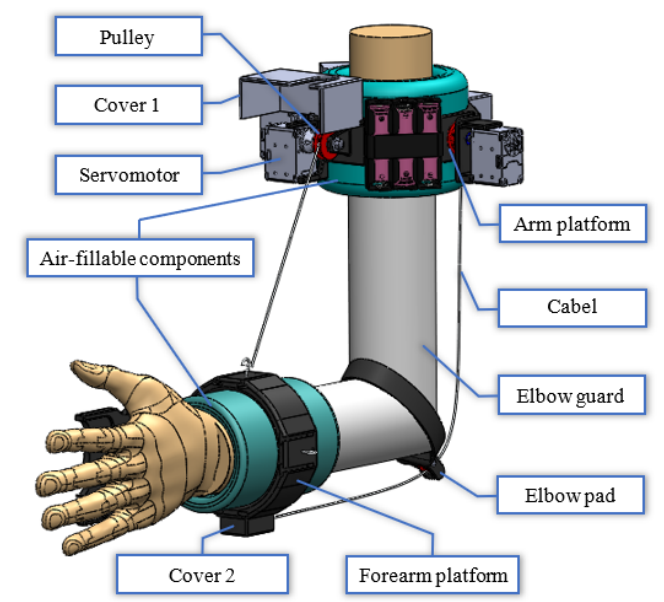
Figure 4. CADEL.3 design with two rigid platforms connected by a flexible elbow